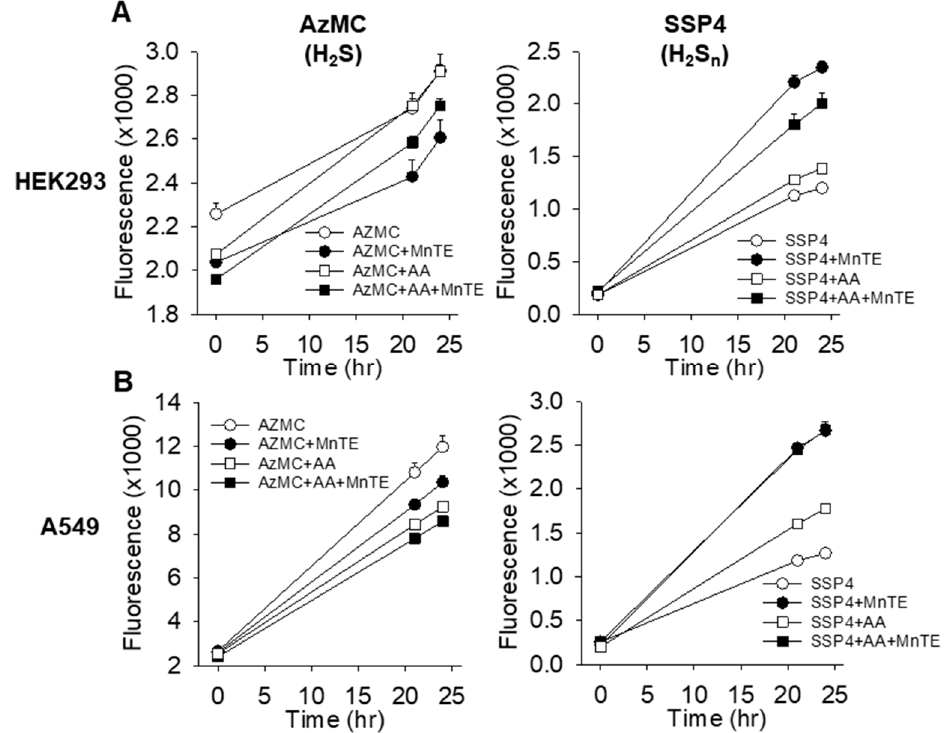
Figure 6. Effects of 1 mM ascorbic acid (AA) on H 2 S and polysulfides (H 2 S n ) alone or in combination with 1 μ M MnTE in HEK 293 ( A ) and A549 ( B ) cells. MnTE decreased H 2 S and increased polysulfides. AA alone did not affect H 2 S in HEK 549 cells but reduced H 2 S in A549 cells and increased polysulfides in both cell lines. AA plus MnTE decreased polysulfdes compared to MnTE alone in HEK 293 cells but did not affect A549 cells. Mean + SE, n = 8 wells per treatment.